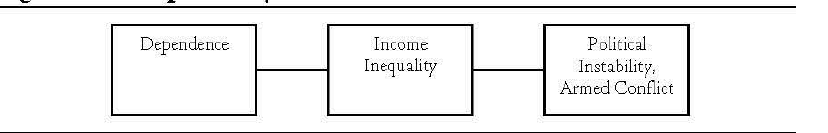
Figure 2: A Dependency